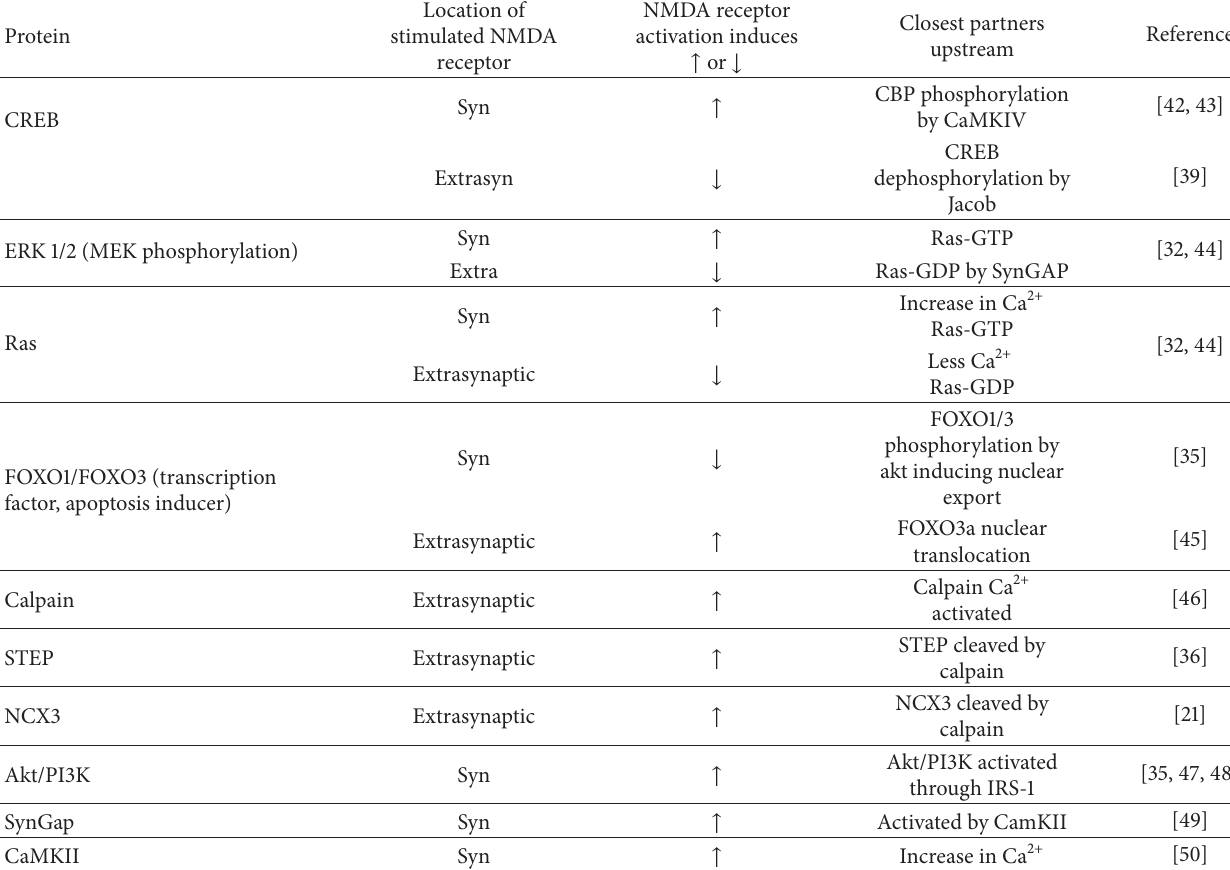
Table 1: Proteins involve in location-dependent NMDAR signaling